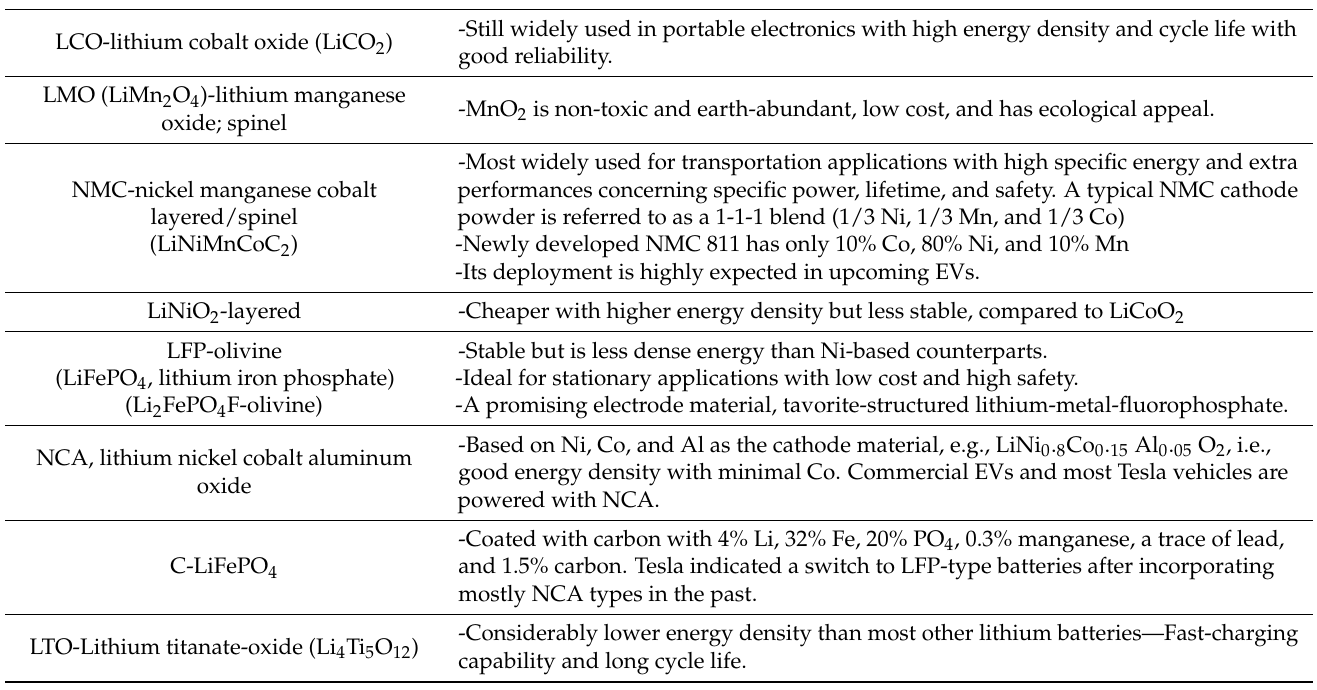
Table 6. Type of electrodes (cathodes) and their characteristics. Electrode-Structure General Remarks and